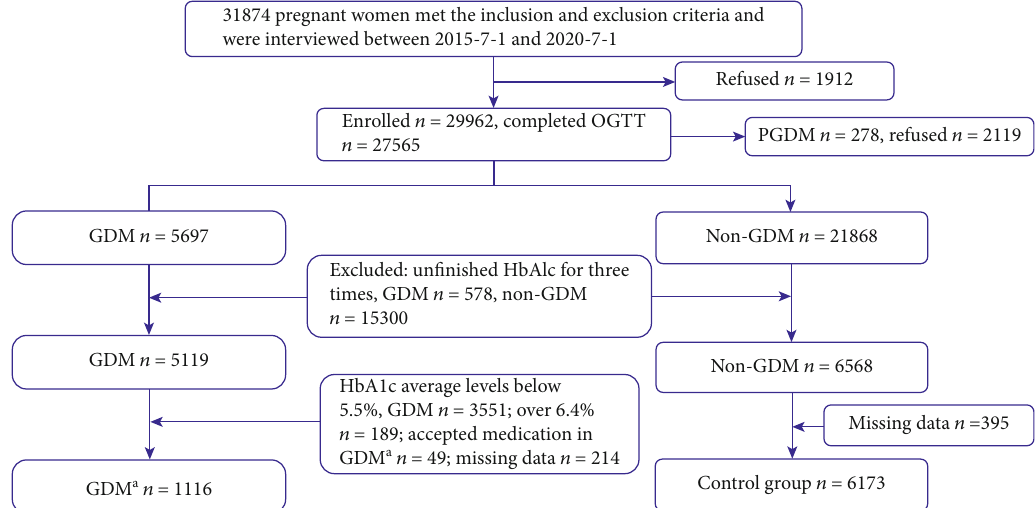
Figure 1: Subjects ’ fl owchart. It shows a series of details on the follow-up. 7289 pregnant women completely fi nished the follow-up between 2015-7-1 and 2020-7-1. HbA1c test each month with missing details: (1) 24-28 weeks at the fi rst time GDM n = 0 , non-GDM n = 654 ; (2) both 28-32 weeks and 32-36 weeks GDM n = 0 , non-GDM n = 12924 ; (3) before the delivery GDM n = 0 , non-GDM n = 1722 . Missing data included out of the delivery in three centers: GDM n = 159 , non-GDM n = 195 ; incomplete clinical data: GDM n = 12 , non-GDM n = 18 ;blood sample problems: GDM n = 34 , non-GDM n = 171 ; or rejected to follow: GDM n = 9 , non-GDM n = 11 . PGDM: pregestational diabetes mellitus; GDM: gestational diabetes mellitus; HbA1c (%): glycated haemoglobin. a Glycosylated haemoglobin monitoring range is IADPSG criteria ( fasting ≥ 5 : 1 mmol/L , 1 h ≥ 10 : 0 mmol/L , and 2 h ≥ 8 : 5 mmol/L ). Recruited subjects accepted the stan- dard of treatment for GDM.